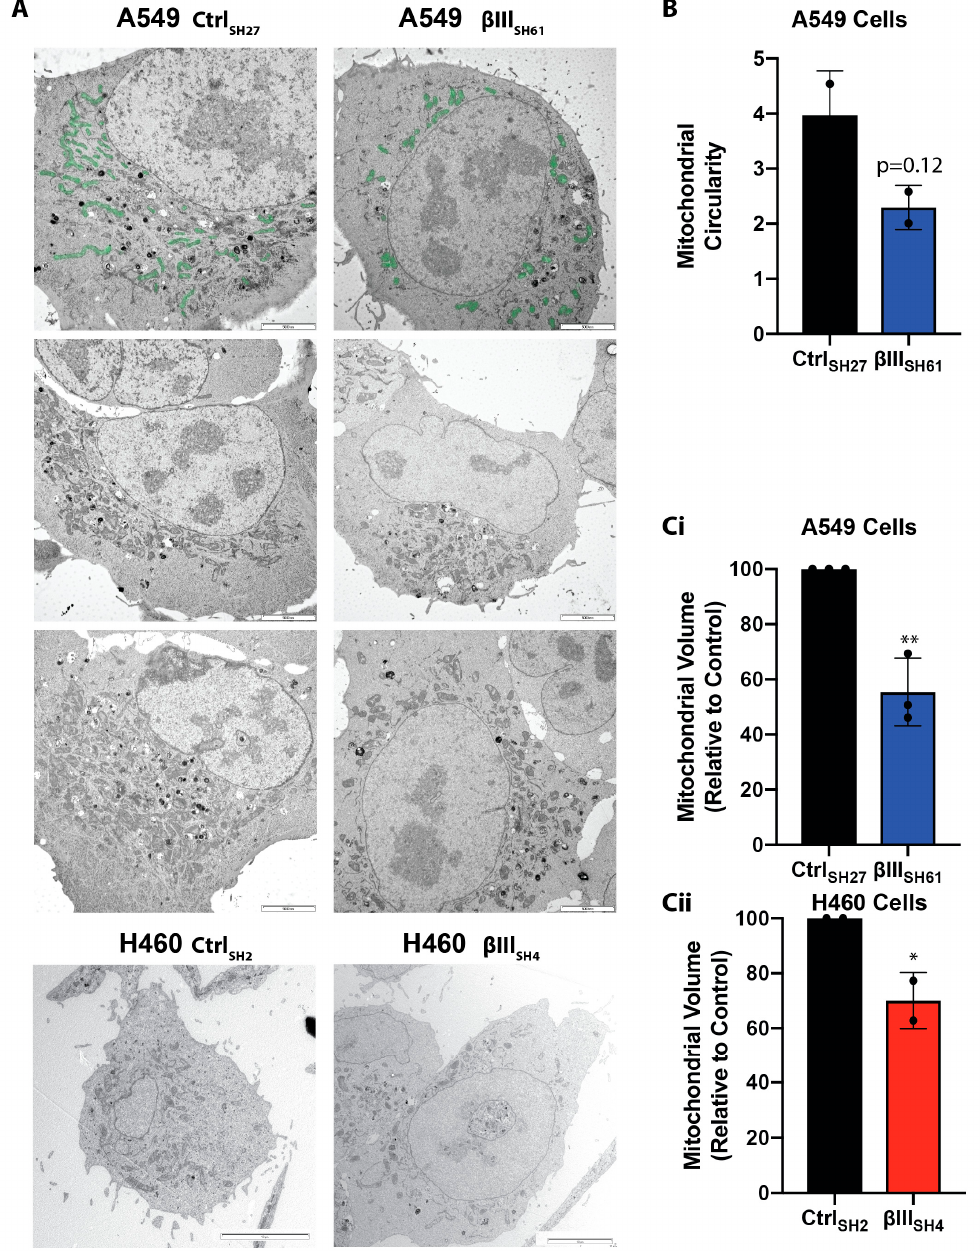
Figure 2. β III-tubulin regulates mitochondrial volume. ( A ) Representative electron micrographs